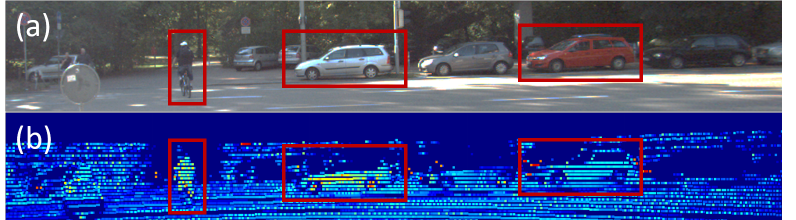
Figure 5. Visualization of ( a ) RGB image and ( b ) LiDAR intensity. Observing the red bounding boxes, the objects with higher LiDAR intensity have the clearer structural features in both RGB image and LiDAR point